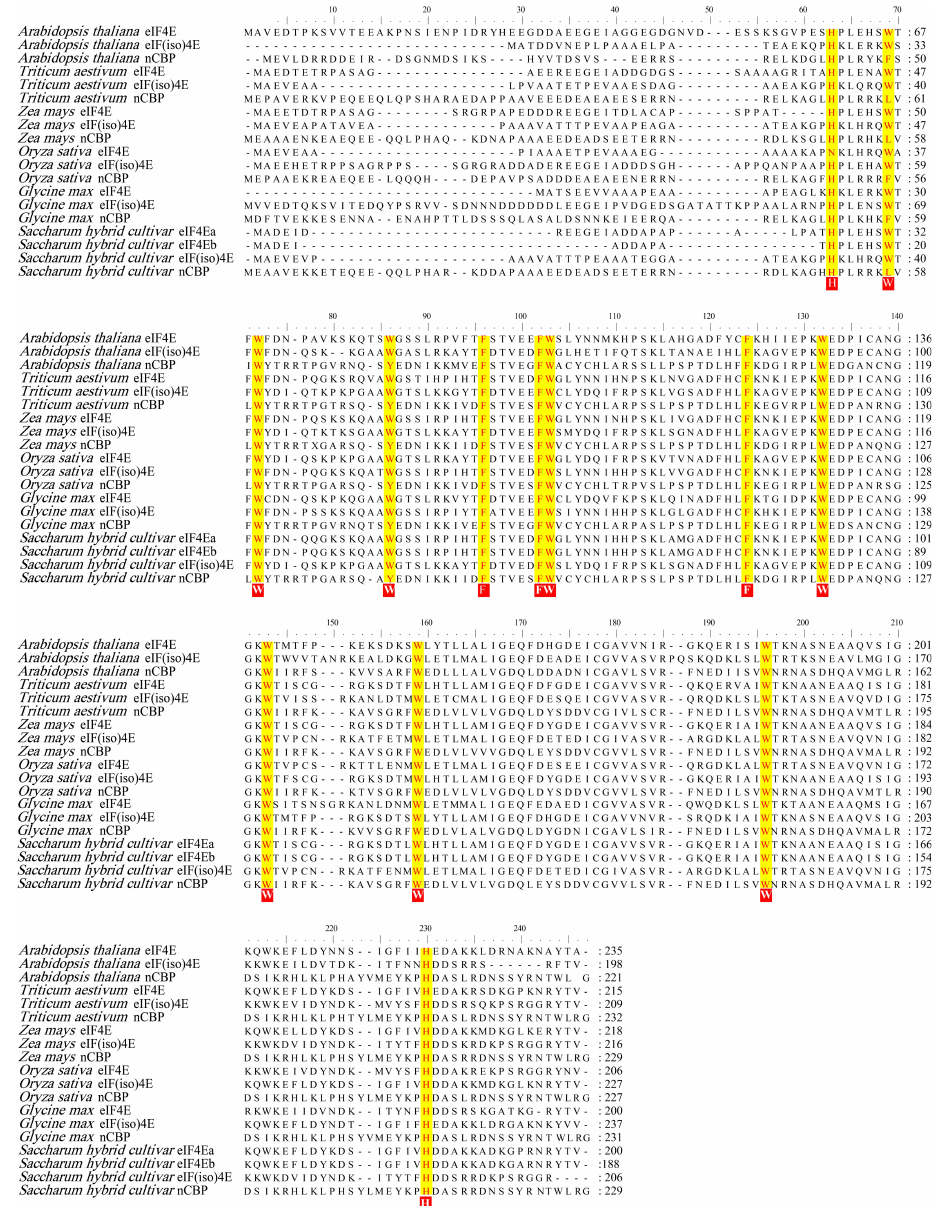
Figure 1. Alignment of the amino acid sequences of the eIF4E, eIF(iso)4E, and nCBP from sev- eral plant species. The accession numbers of the selected amino acid sequences were Arabidop- sis thaliana : eIF4E (AT4G18040), eIF(iso)4E (AT5G35620), nCBP (AT5G18110); Triticum aestivum : eIF4E (CAA78262), eIF(iso)4E (AAA34296), nCBP (XM.037569593); Zea mays : eIF4E (AF076954), eIF(iso)4E (CD527566), nCBP (EU959765); Oryza sativa : eIF4E (U34597), eIF(iso)4E (U34598), nCBP (CF328046); Glycine max : eIF4E (BI785638), eIF(iso)4E (BG045933), nCBP (BE474869); Saccharum spp. hybrid ROC22 : SceIF4Ea (MW547070), SceIF4Eb (MW547071), SceIF(iso)4E (MW547073), Sc- nCBP (KX757019). Conserved Trp, Phe, and His residues were yellow shaded: H(X5)W(X2)W(X8– 12)W-(X9)F(X5)FW(X20)F(X7)W(X10)W(X9–12)W(X34–35)W(X31–33)H. Numbers to the right of the sequences indicate the positions of residues from the N-terminal